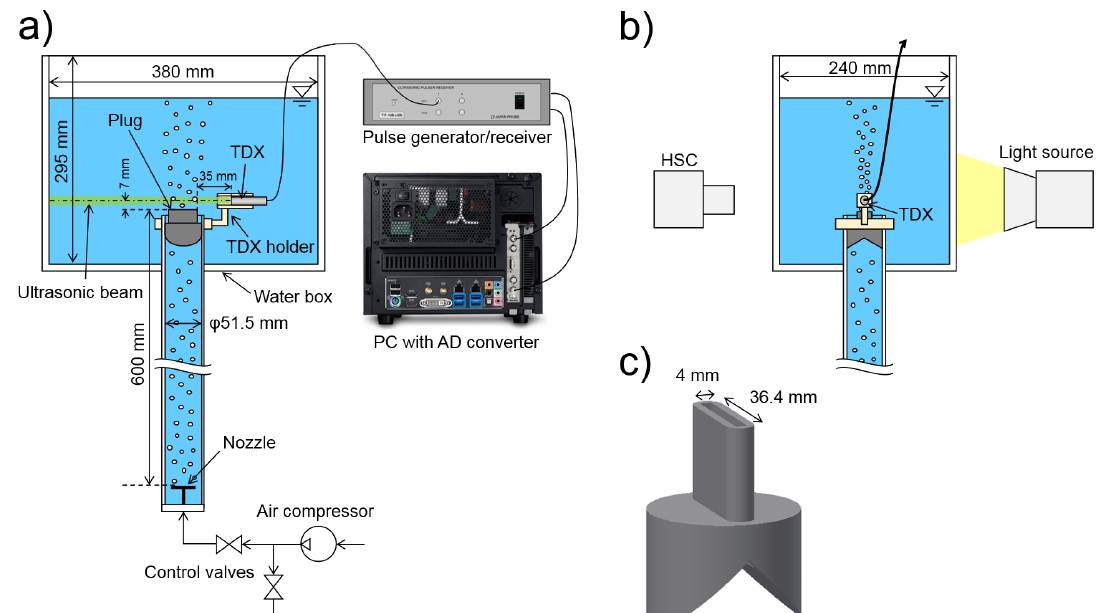
Figure 4. Experimental apparatus: ( a ) The front view. ( b ) The side view. ( c ) The detail of the plug